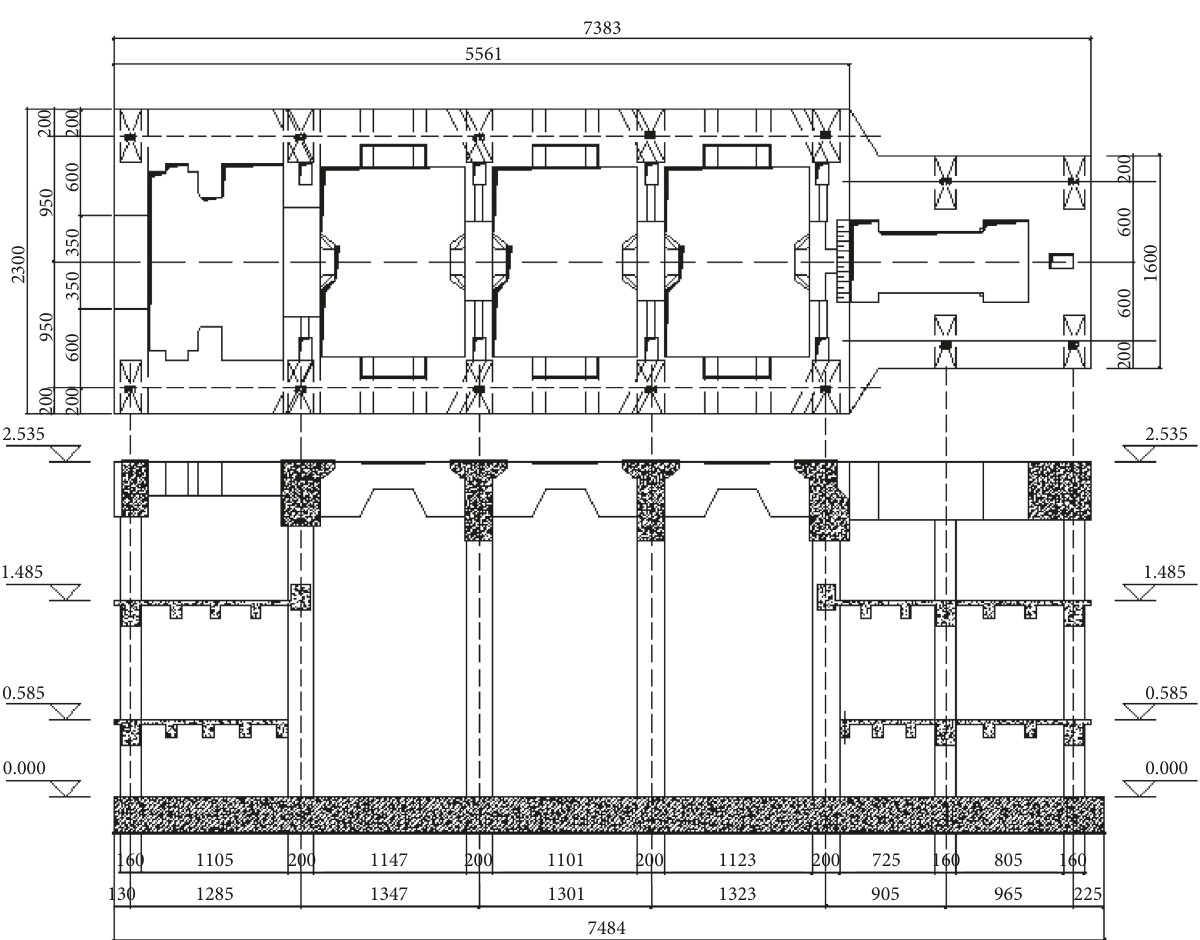
Figure 1: Layout drawing of test model (mm).